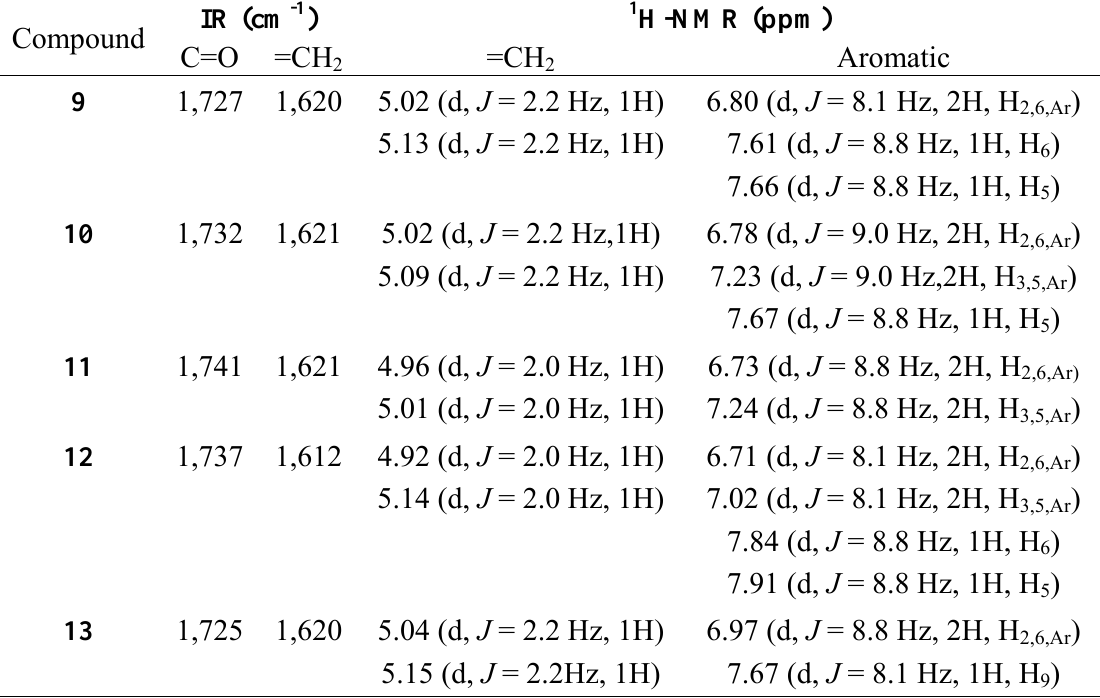
Table 3 . Partial IR and NMR data for compounds 9-16